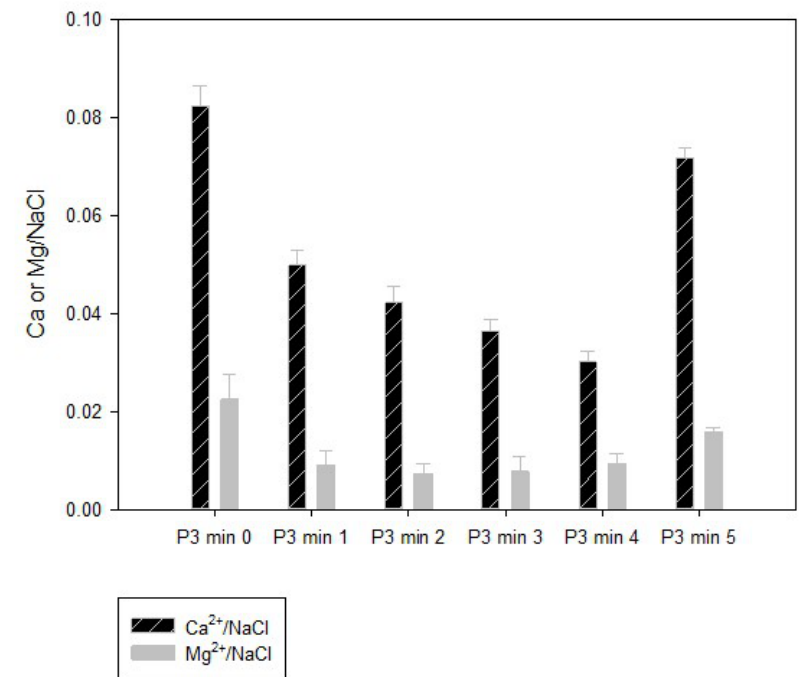
Figure 3. Calcium and magnesium relation to NaCl in the softener water (P3: step 3 of the spent brine generation).